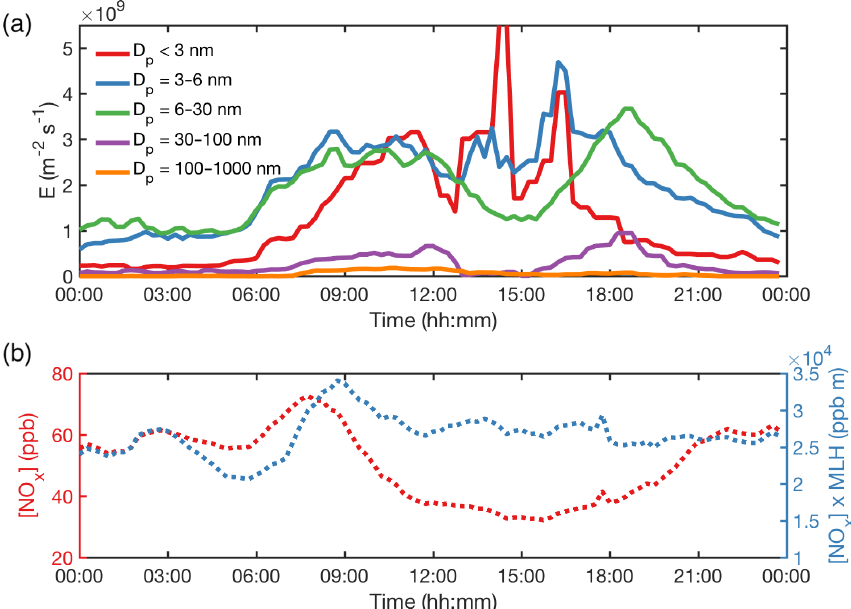
Figure 5. Average diurnal cycles of (a) particle number emissions into different size ranges on non-NPF event days and (b) the concentration of NO x (nitrogen oxidizes) and its product with MLH (mixing layer height). For particle number emissions depicted on a logarithmic scale, see Fig. A2 in the Appendix.